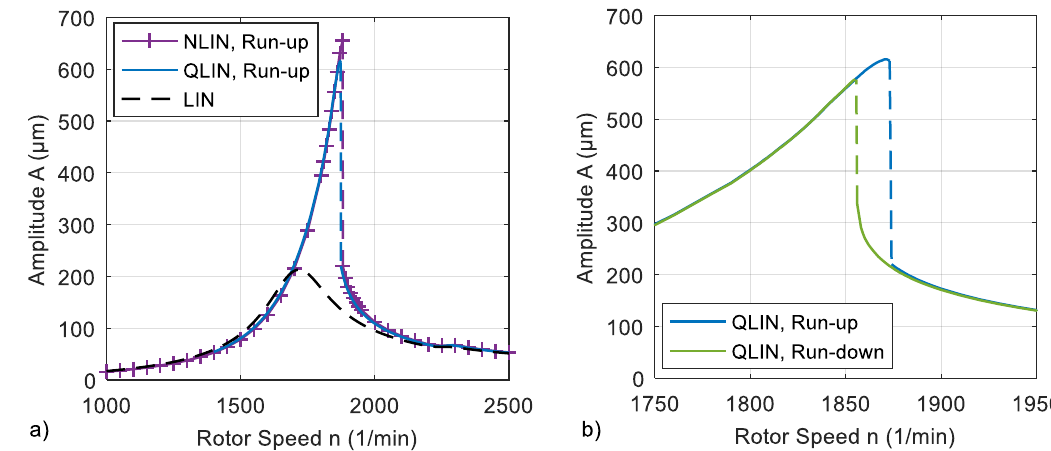
Figure 12. Generator amplitude response, unbalance G6.3 (40%) for linear (LIN), quasi-linear (QLIN) and non-linear (NLIN) analyses (variant 1): ( a ) comparison of different analysis types; ( b ) hysteresis between the run-up and the run-down (QLIN).